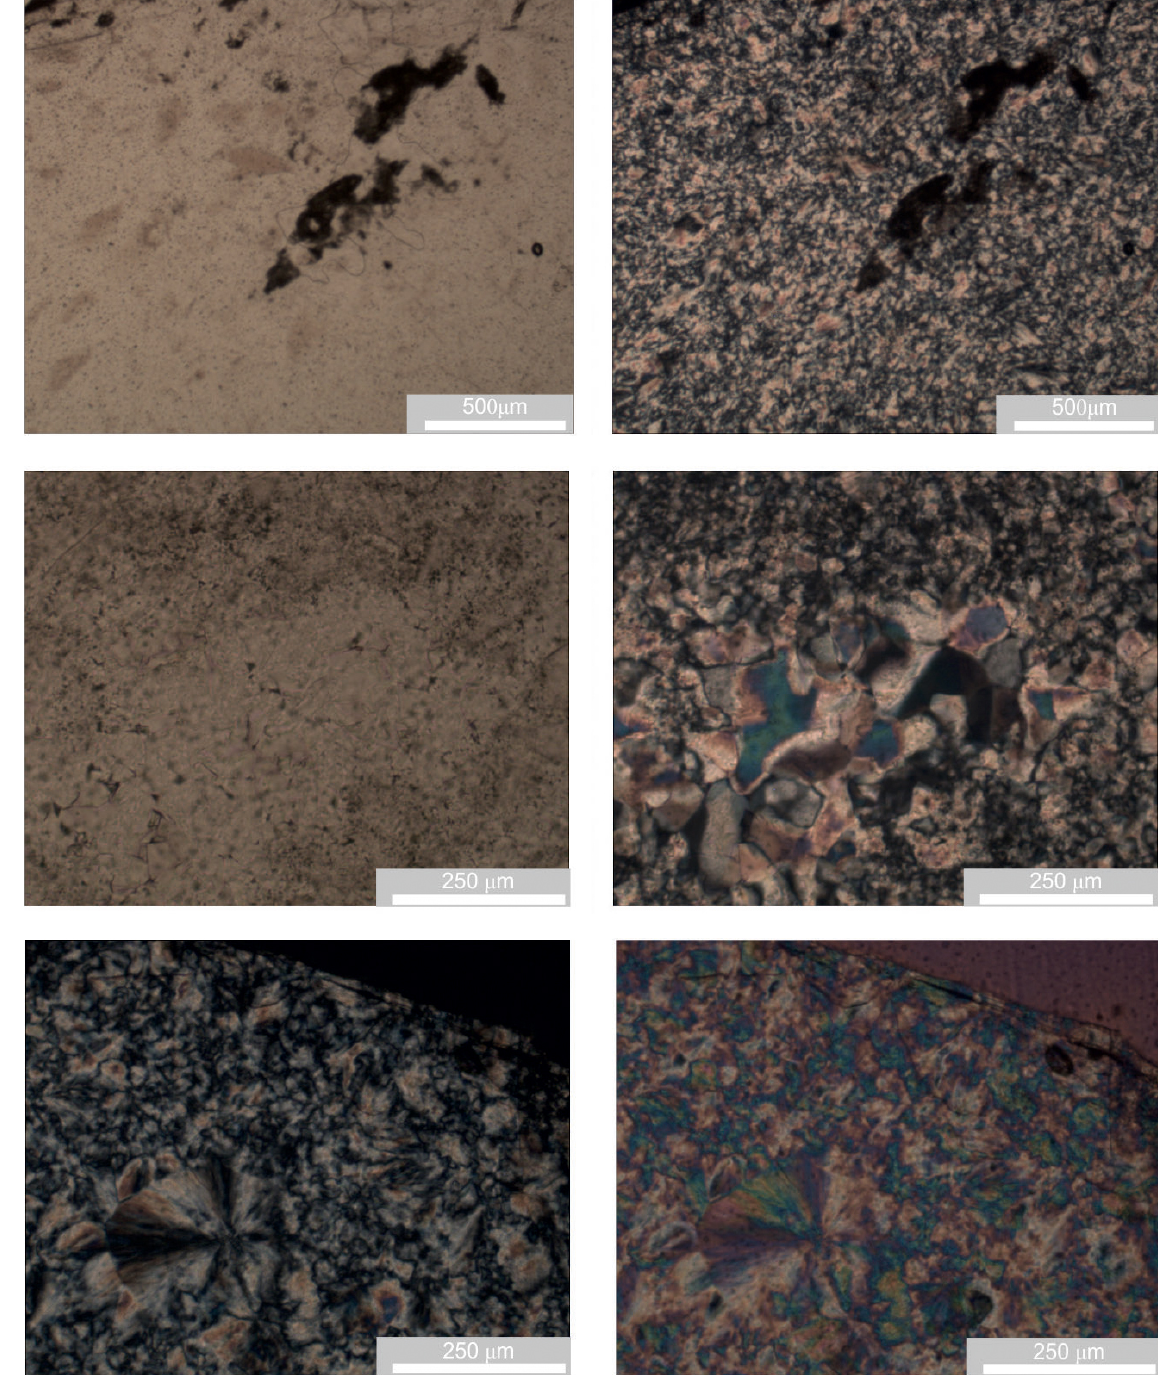
Figure 9. Thin section images of Maset 2 chert. Gypsum pseudomorphs with haematite concentrations (Above); chemical dissolution cavities cemented by macrocrystaline quartz in mosaic (centre); replacement of the primary depositional texture by microcrystalline quartz and length-positive fibrous quartz